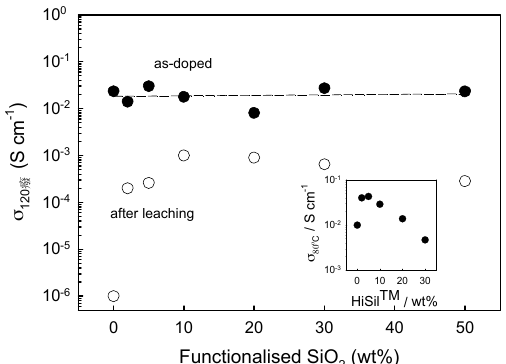
Figure 4. Proton conductivity vs. the filler content at 120 °C and 50% relative humidity, both for the as-prepared membranes and after leaching. The inset shows the proton conductivity behaviour